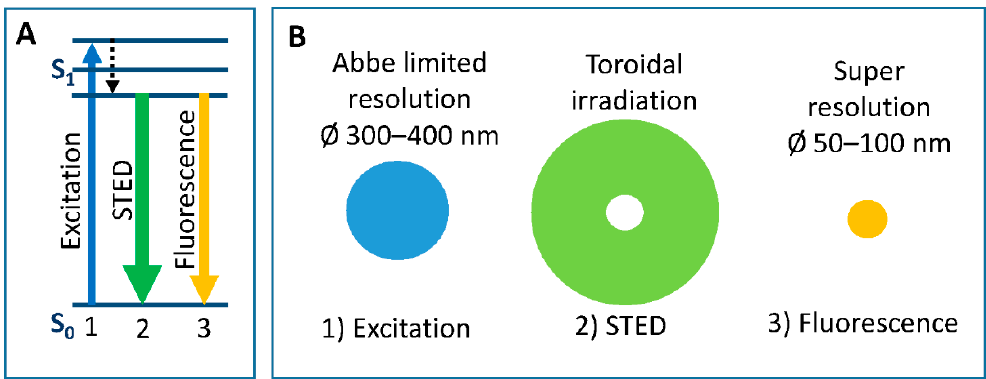
Figure 7. Sequences for STimulated Emission Depletion (STED) nanoscopy. ( A ) Energy diagram; ( B ) Spatial distribution. (1) Excitation, (2) deactivation of peripheral fluorophores by toroidal STED